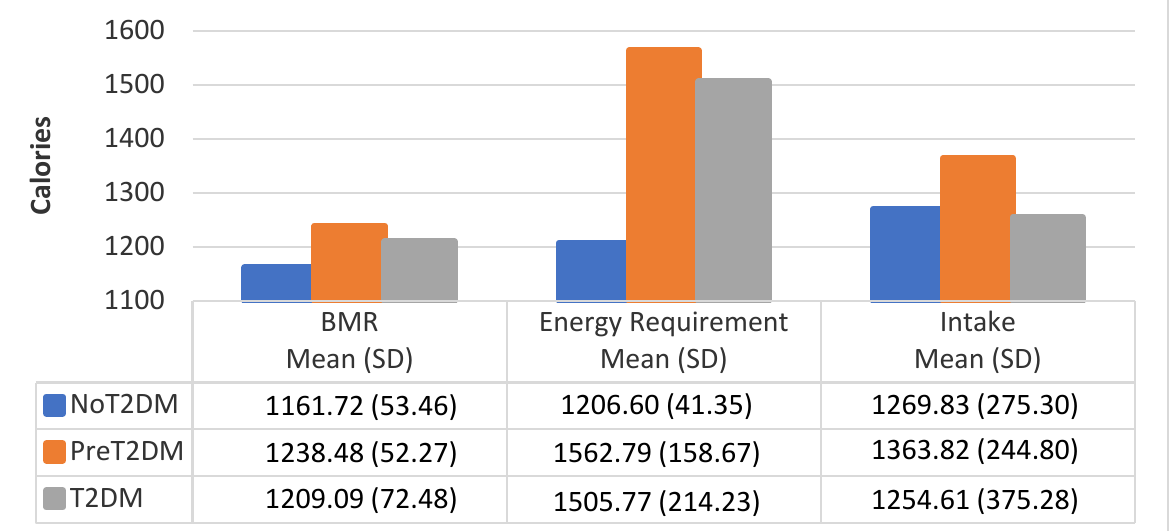
Figure 3. BMR, energy requirement, and caloric intake for all participants by diabetes status.